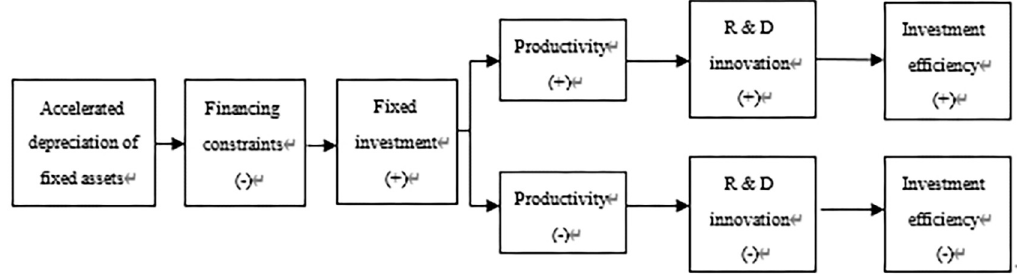
Fig 1. The mechanism of the accelerated depreciation policy of fixed assets affecting the investment efficiency of enterprises.